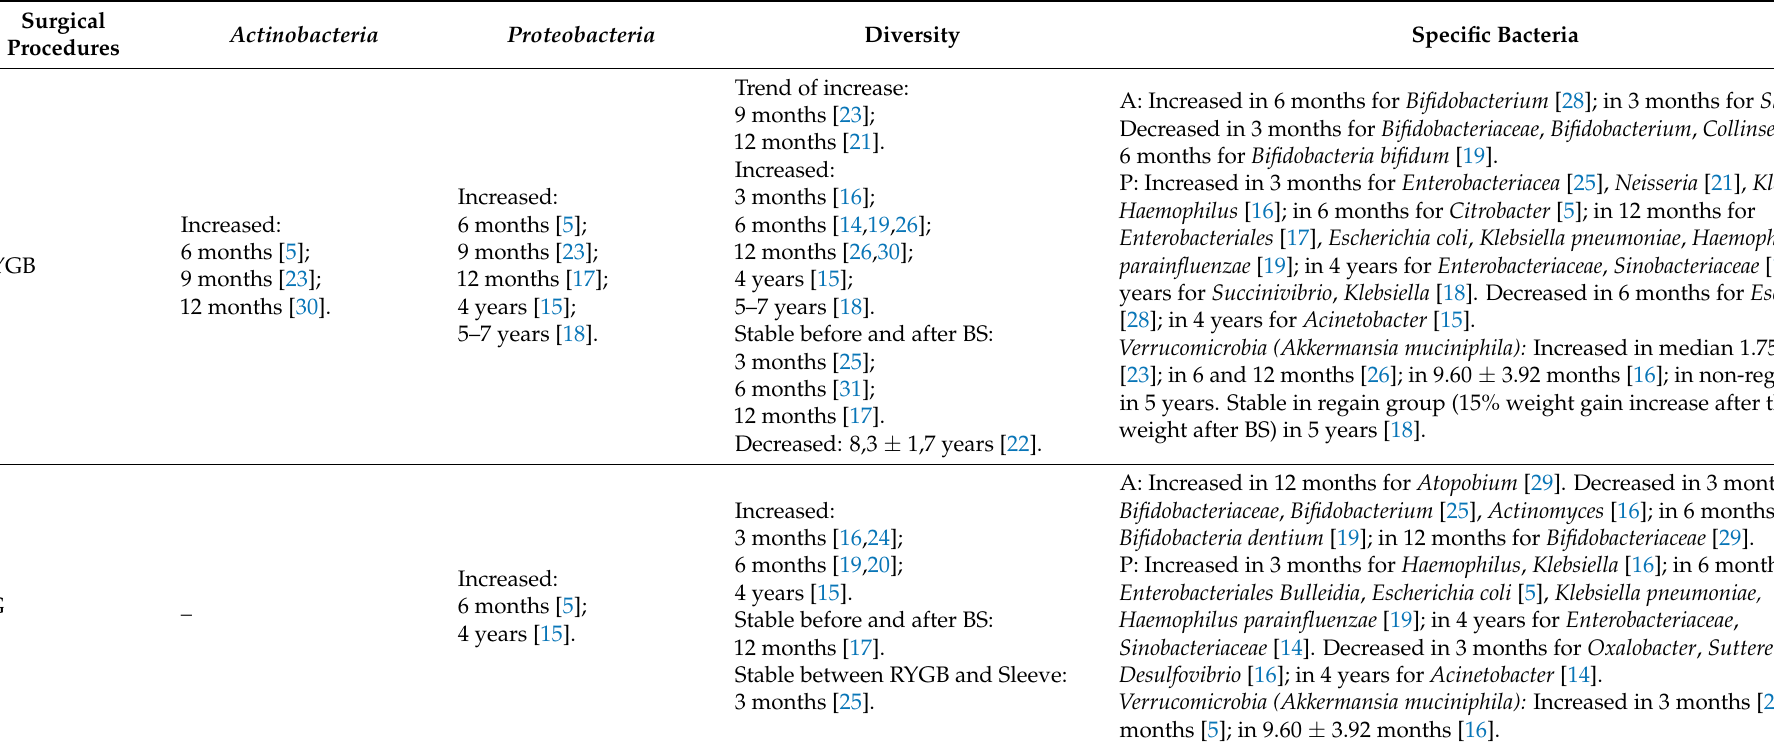
Table 4. Comparison of Actinobacteria , Proteobacteria, diversity, and specific bacteria between the RYGB and SG surgeries.